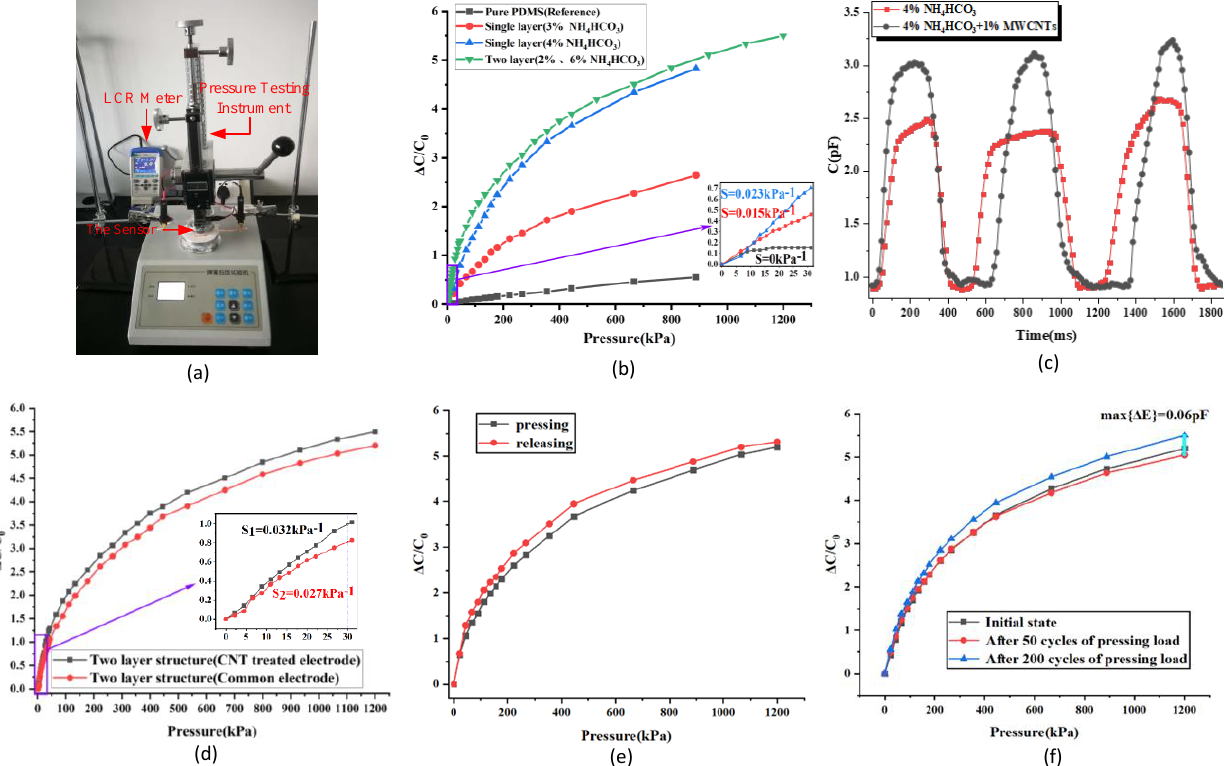
Figure 5. The testing system and the testing results: ( a ) the testing system. ( b ) The sensitivity of the sensors. ( c ) The sensitivity of the sensors with copper electrodes and electrodes treated with CNTs. ( d ) The press testing of the sensors with dielectric doped CNTs and not doped CNTs. ( e ) The hysteresis test results of the sensor. ( f ) The repeatability test results of the sensor.